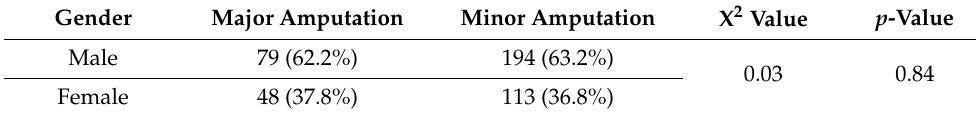
Table 8. Association between gender and types of amputations.